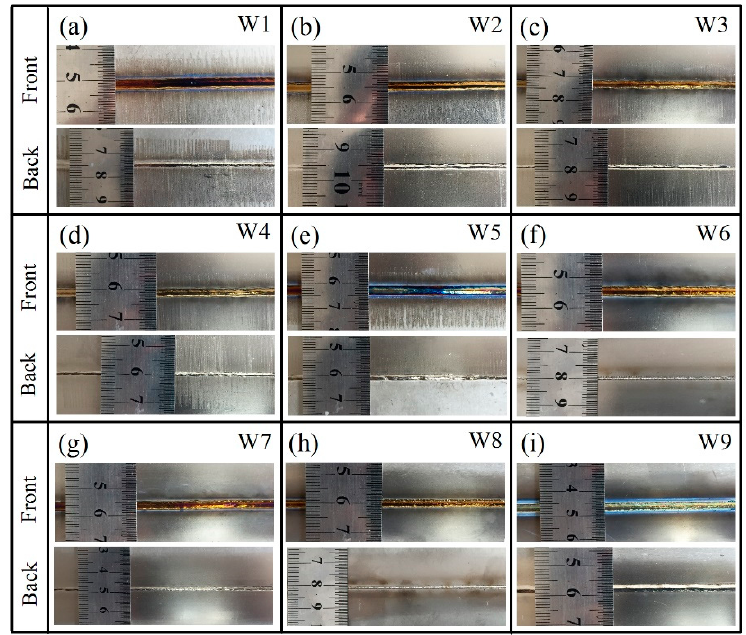
Figure 2. The front and back appearances of the laser-welded TC31 joints: ( a – i ) represent W1 to W9 samples.